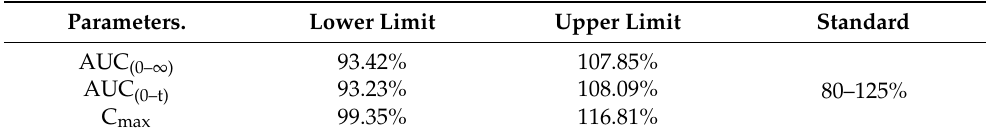
Table 4. Results of bioequivalence evaluation.